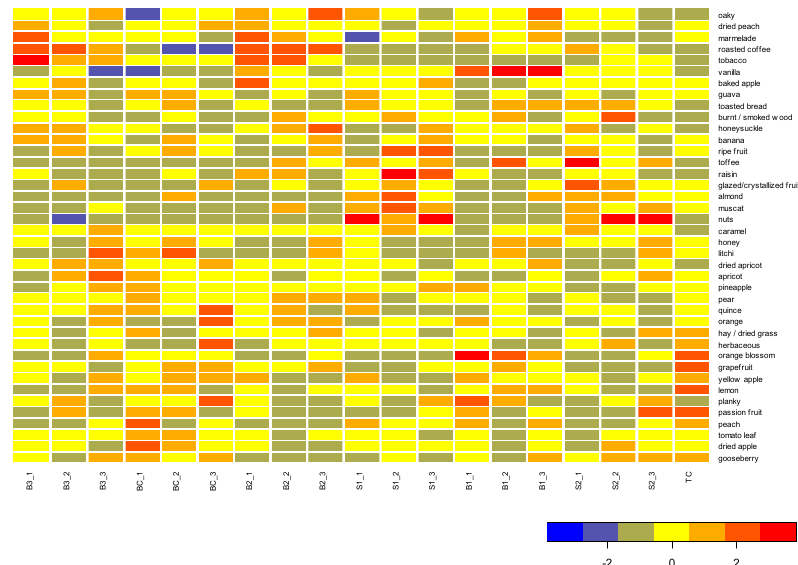
Figure A3. Heat maps constructed based on the standardized residuals that were generated by the correspondence analyses of individual repeats obtained with the trained panel ( n = 20) after 9 months of oak maturation. The more negative (i.e., the more “blue” on the heatmap) the residuals, the more indication that the correspondence (co-occurrence) between the items are less than what would be expected under the assumption of complete random occurrence. And vice versa, the more positive (i.e., the more red on the heatmap) the residuals, the more indication that the co-occurrence are more that expected under complete random occurrence. TC: Tank control, BC: Barrel control, B: New barrel treatments, S: Stave treatments.